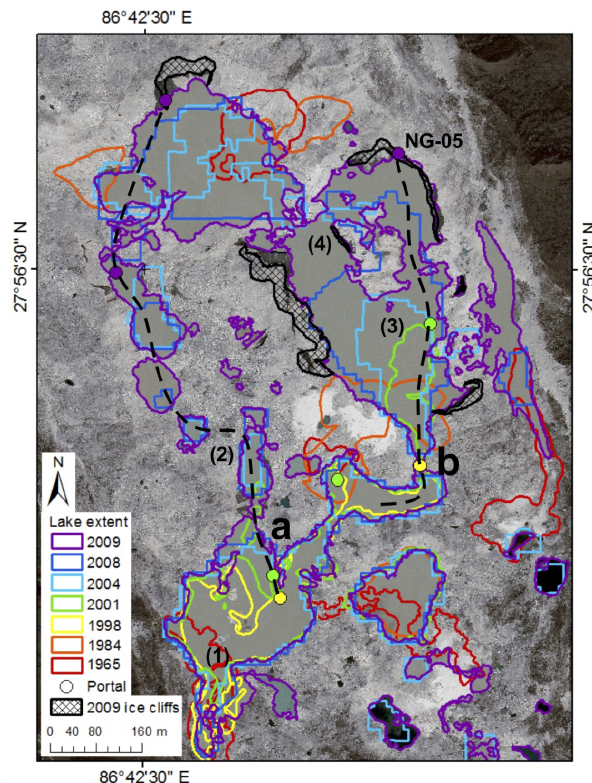
Figure 13. Spillway Lake, 1965–2009, showing the position of meltwater portals and upwellings and the inferred location of for- mer englacial conduits (dashed lines). Background image: GeoEye- 1 from June 2010. See text for explanation of lake